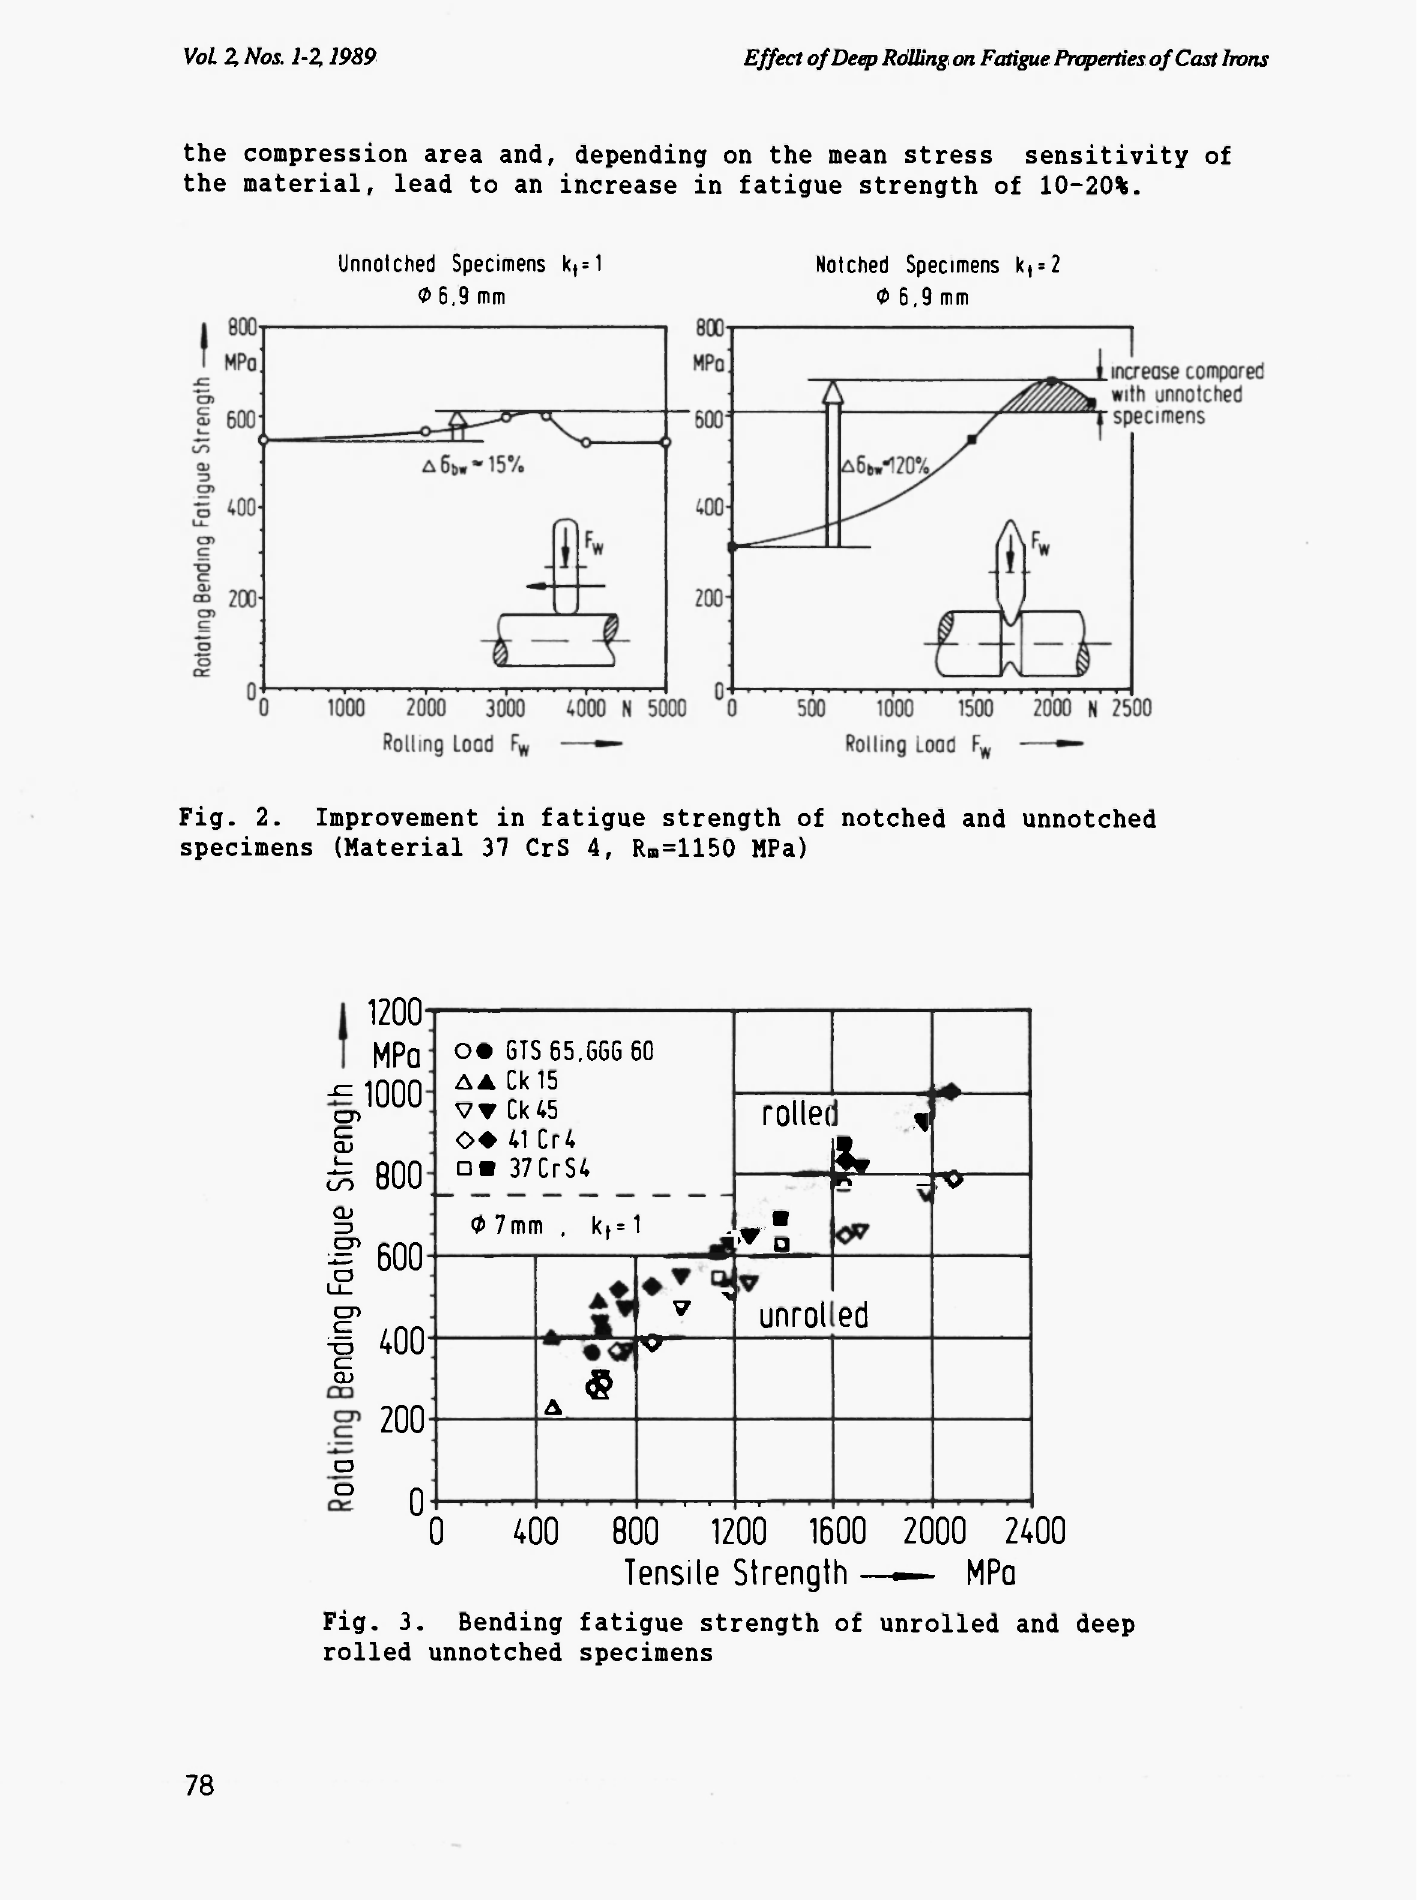
Fig. 3. Bending fatigue strength of unrolled and deep rolled unnotched